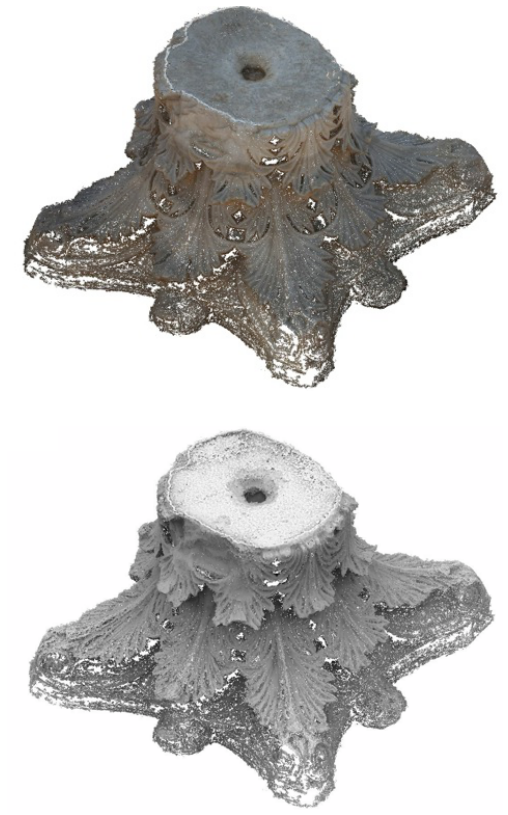
Figure 3: point cloud of a capital from St. Hilarion Monastry by photogrammetry, without color on the bottom, colored on the top Level 4: